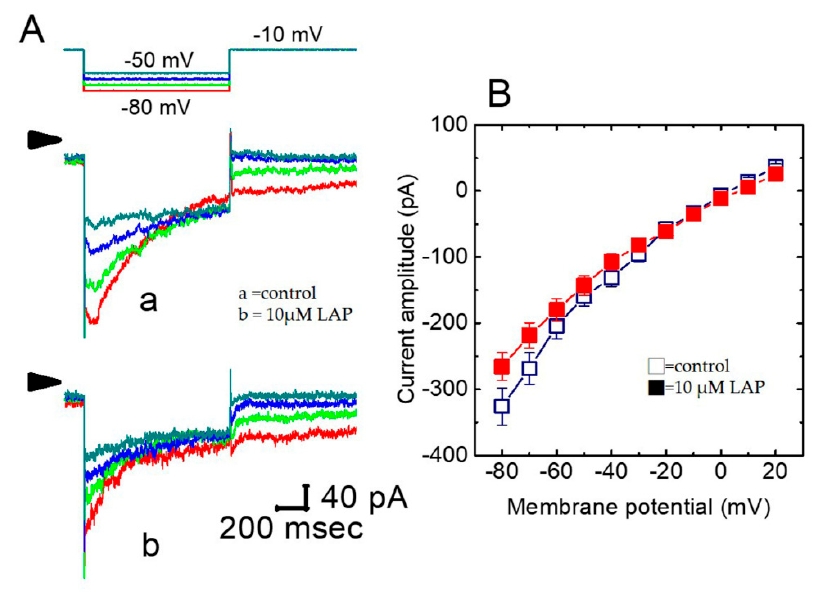
Figure 3. Effect of LAP on erg -mediated K + current ( I K(erg) ) in H9c2 cells. ( A ) Superimposed current traces obtained when the cell was 1-sec hyperpolarized from − 10 mV to various potentials, as indicated in the uppermost part. Current traces labeled ‘a’ are the controls and those labeled ‘b’ were obtained in the presence of 10 μ M LAP. The different colors depicted in current traces of ‘a’ and ‘b’ correspond to those in the voltage protocol applied (the uppermost part). ( B ) Averaged I – V relationships for the peak amplitude of deactivating I K(erg) in the absence ( □ ) and presence ( ■ ) of 10 μ M LAP ( n = 9–10 for each point). Current amplitudes were measured at the beginning of each hyperpolarizing pulse.